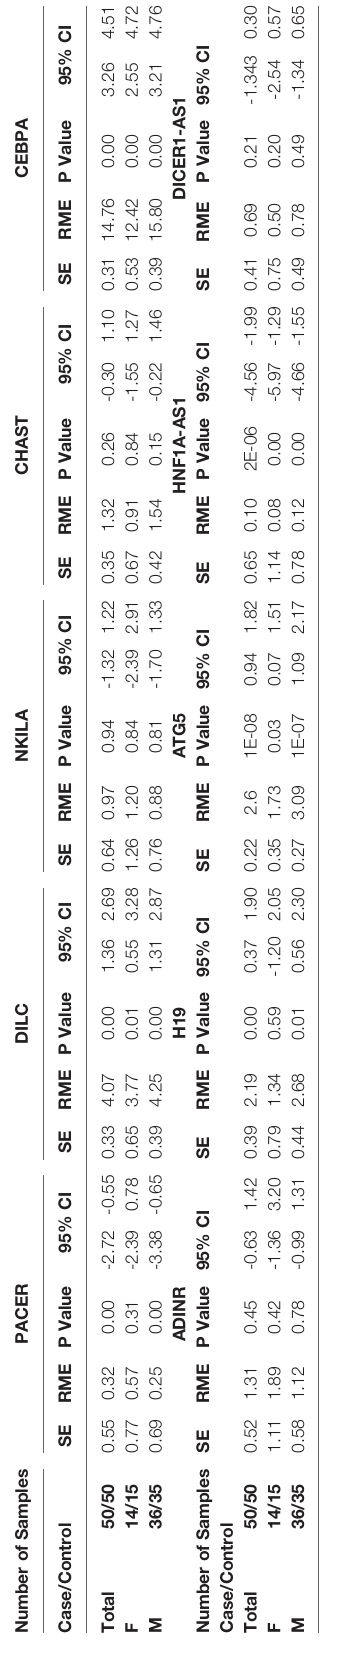
FIGURE 3 | Correlation matrix for illustration of correlation between expression levels of NF- k B-related lncRNAs among controls (The distribution of expression levels of each lncRNA in controls is shown on the diagonal. Bivariate scatter plots are shown on the bottom of the diagonal. R and P values are shown on the top of the diagonal).